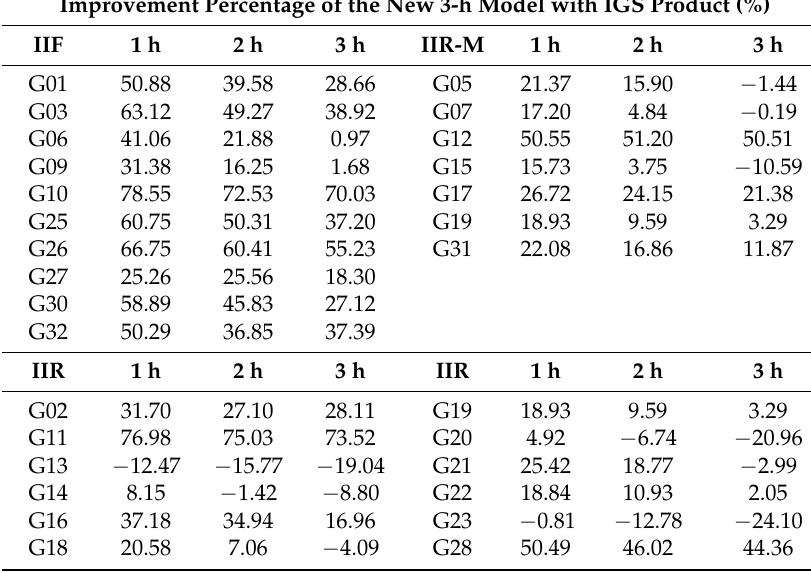
Table 4. Corresponding improvement percentage of the new